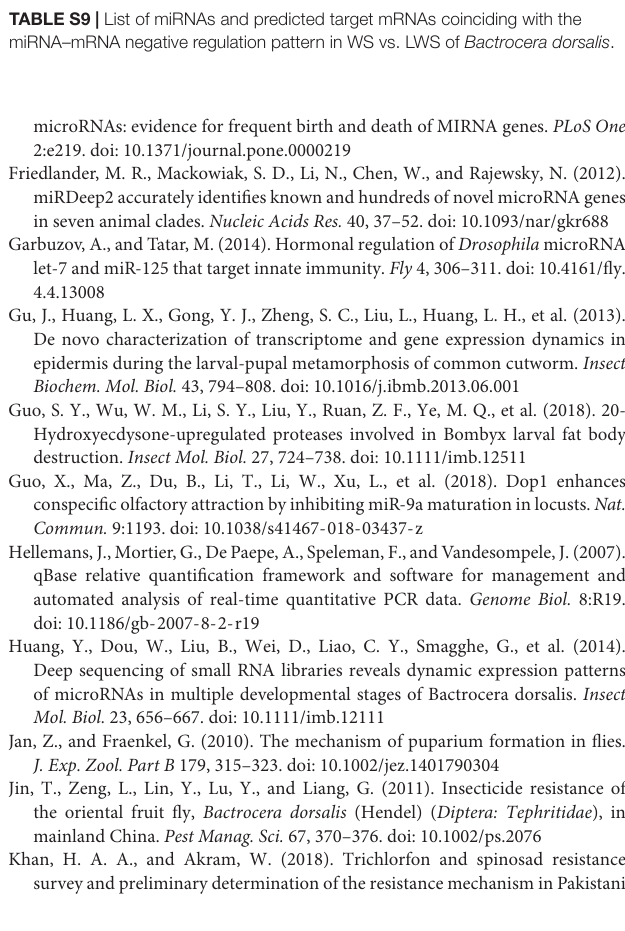
FIGURE S1 | GO classification analysis for predicted differentially expressed genes (DEGs) of differentially expressed miRNAs (DEMs) in WS vs. LWS. (All secondary level was under the backgrounds of the predicted DEGs and the predicted target genes of DEMs). FIGURE S2 | COG classification analysis for predicted differentially expressed genes (DEGs) of differentially expressed miRNAs (DEMs) in WS vs. LWS. FIGURE S3 | KEGG classification analysis for predicted differentially expressed genes (DEGs) of differentially expressed miRNAs (DEMs) in WS vs. LWS. TABLE S1 | Primers of miRNA and mRNA used in our study. TABLE S2 | Overview of sRNA sequencing data. TABLE S3 | Mapping information of unannotated reads with reference